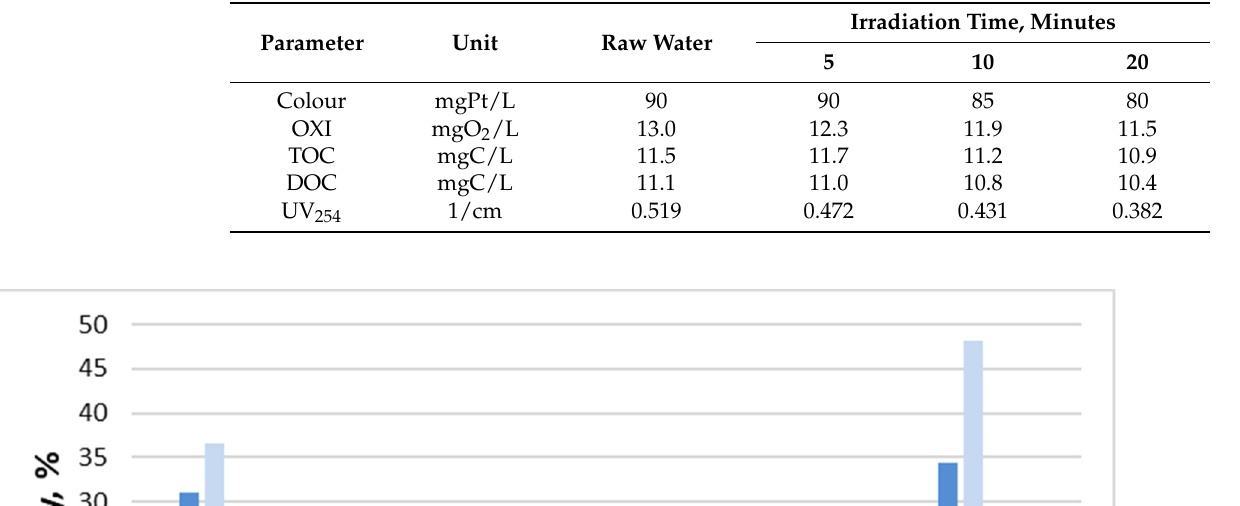
Table 4. Values of selected parameters of raw natural water and water after UV 254 irradiation (low-pressure lamp).